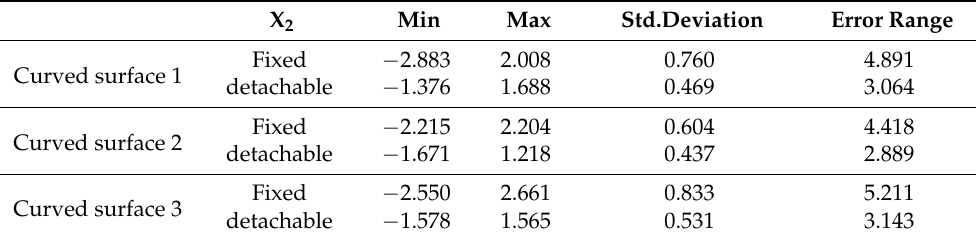
Table 2. Shape error by connection technology according to the shape of curve.